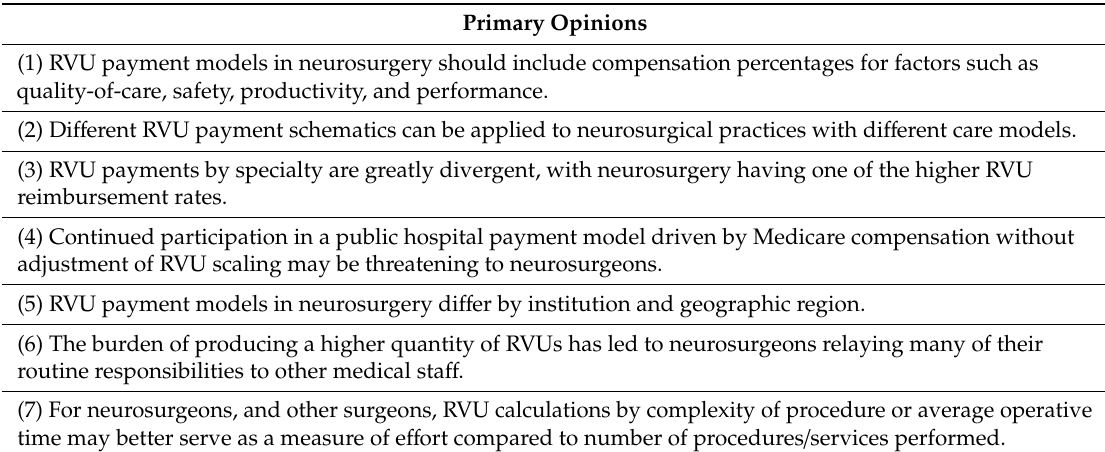
Table 2. Primary Opinions on the RVU in